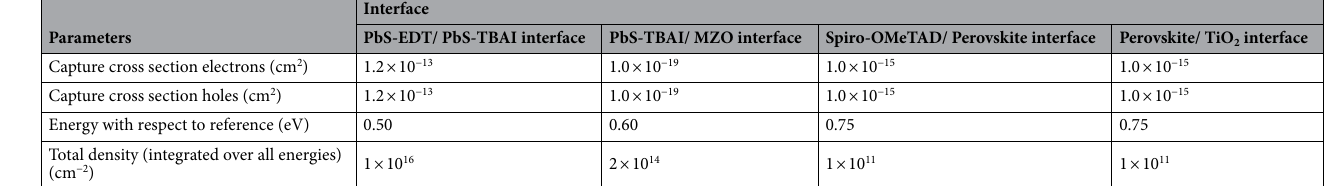
Table 2. Interface defects are considered at different interfaces of the top cell, bottom cell, and tandem solar cell. For all the cases, the defect type is neutral with the single energetic distribution. The reference for defect energy level (E t ) is above the highest E V . For neutral defects, carrier lifetimes are determined using τ n = 1 /(σ n v th N t ) and τ p = 1 / (cid:31) σ p v th N t (cid:30) . Where σ n , σ p , v th , N t are the electron capture cross-section, hole capture cross-section, thermal velocity (10 7 cm/s), and total defect density,